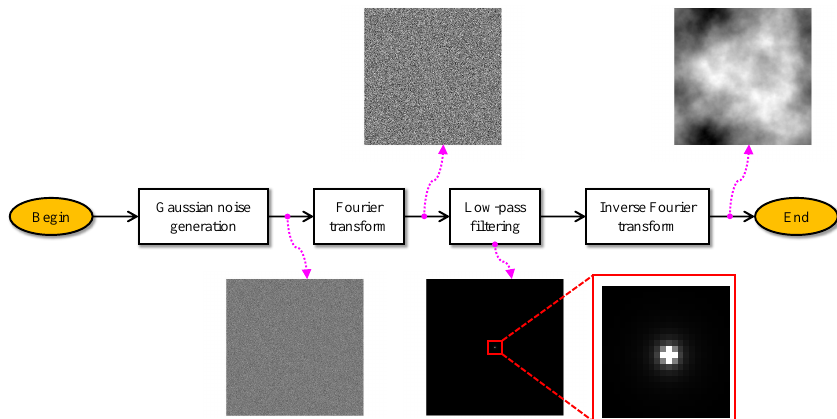
Figure 8. Intuitive illustration of synthetic haze/cloud